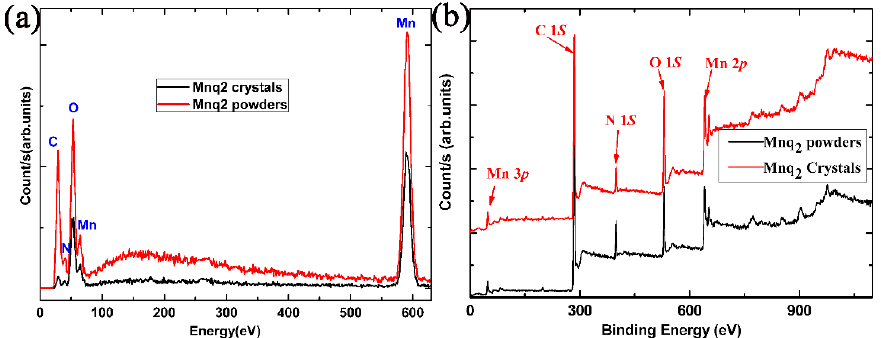
Figure 3. ( a )The EDS spectra of the Mnq 2 powders and prepared Mnq 2 nanorods. ( b ) The XPS survey spectra for the Mnq 2 powders and nanorods.